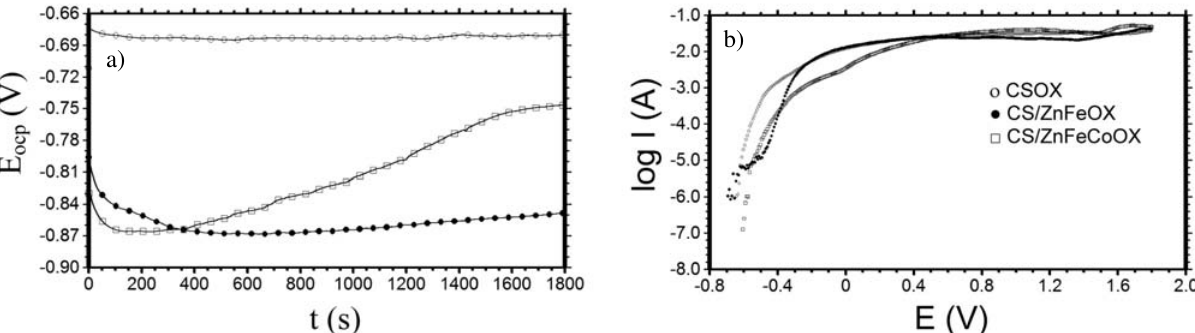
Fig. 10. The E -t diagrams immediately after of immersion time (a) and the anodic polarization curves after 168 h of exposure time (b) obtained ocp for electrodes, in 3.5% NaCl